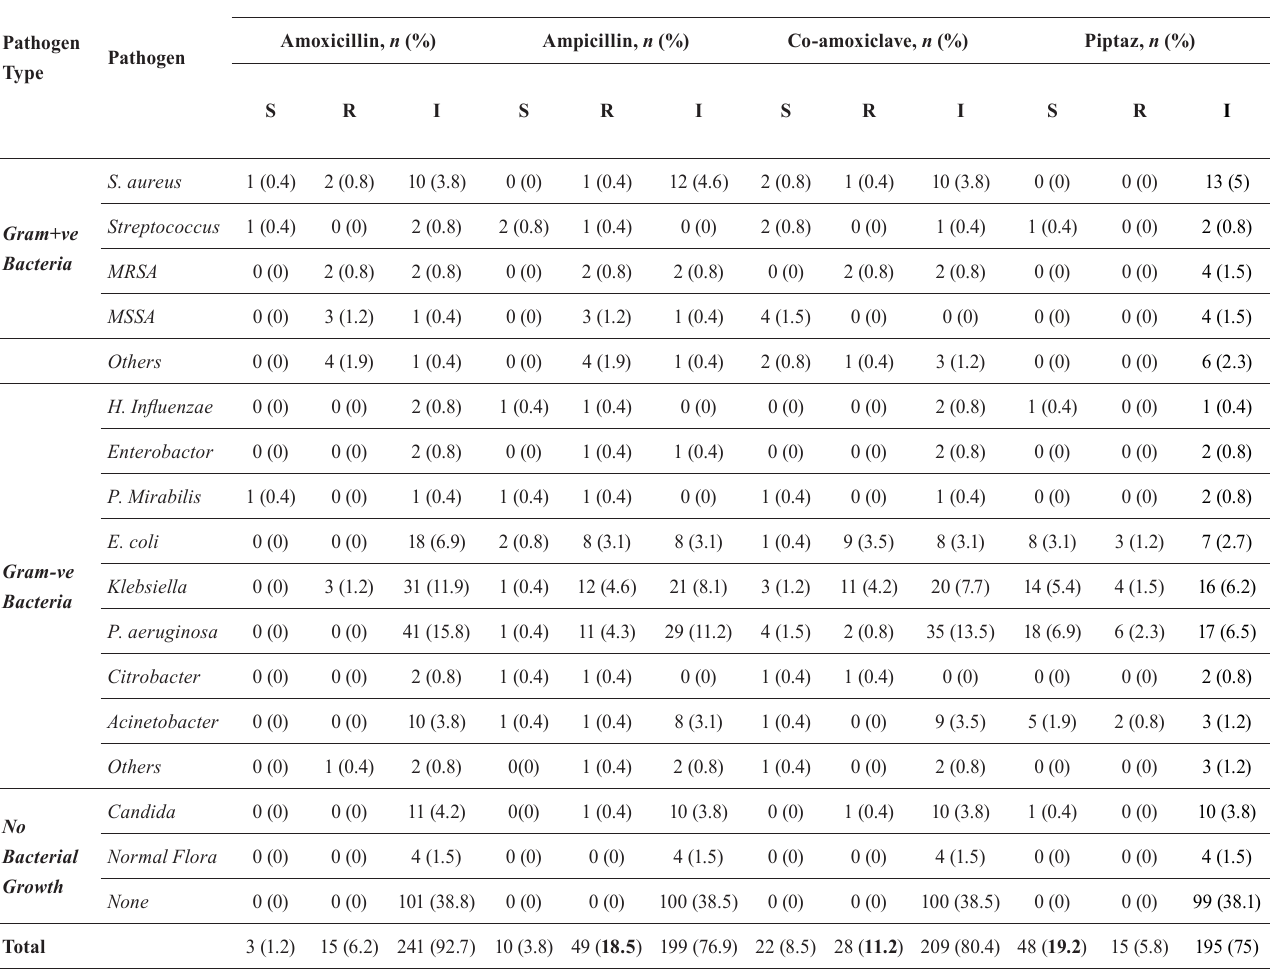
TABLE II - Penicillin Susceptibility Patterns against Respiratory Tract Pathogens